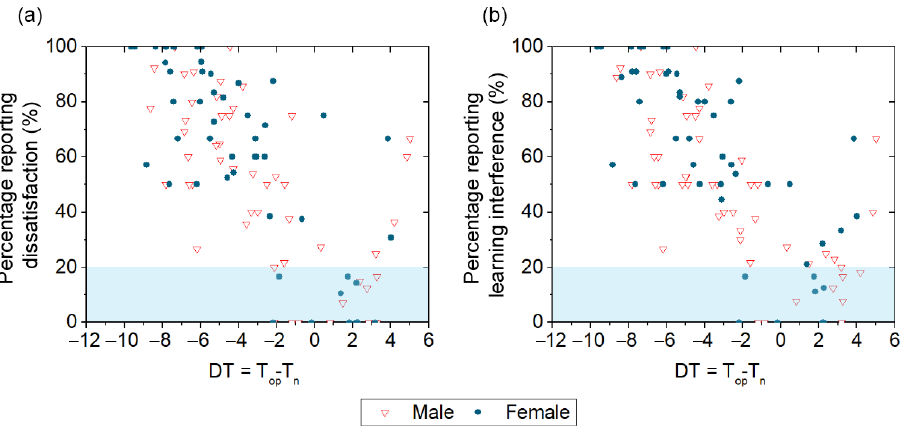
Figure 8. ( a ) Percentage of dissatisfied students versus DT; ( b ) percentage reporting learning in- terference versus TSV. ence versus TSV.